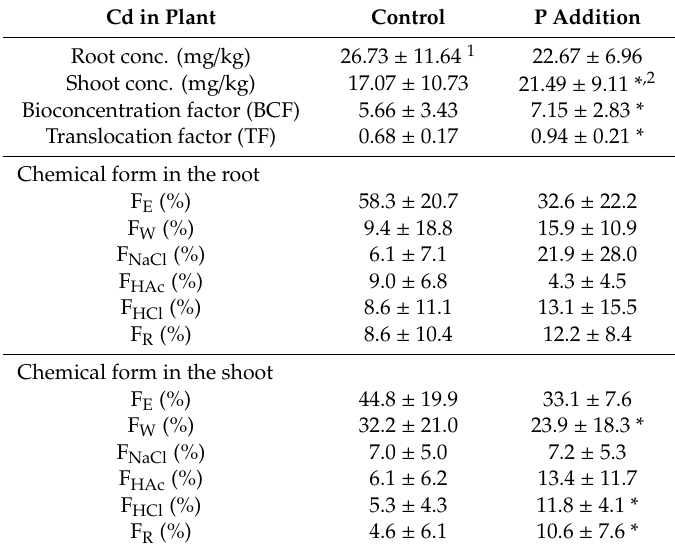
Table 3. Effect of adding P on the accumulation, translocation, and chemical form of Cd in the water